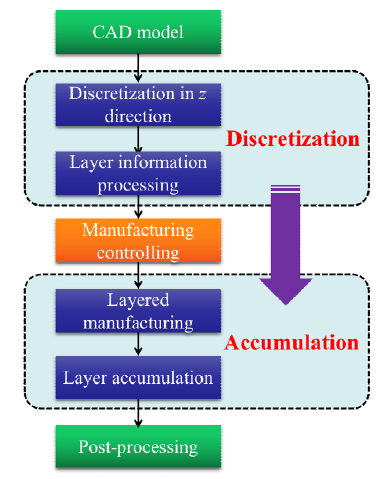
Fig. 2 Schematic diagram of additive